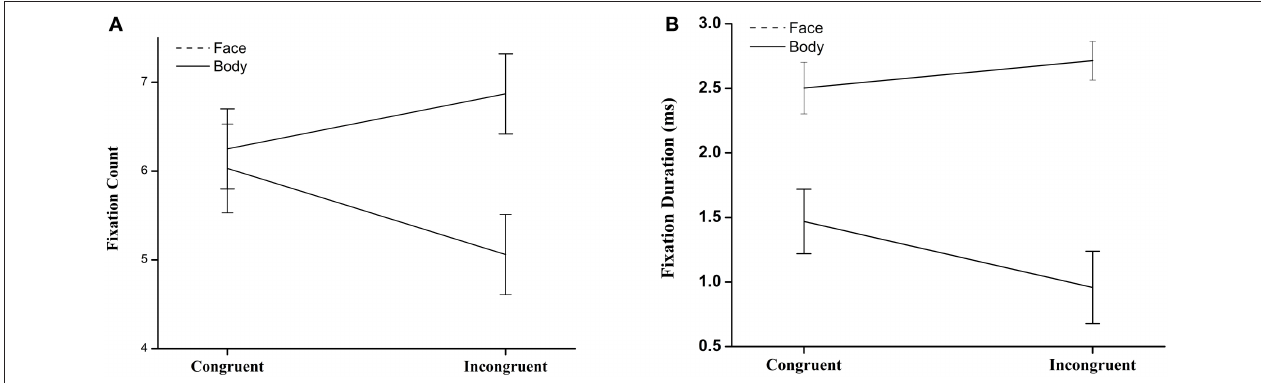
FIGURE 3 | (A) Number of fixation for Regions of Interest (ROI) of face and body in face-body compounds. (B) Fixation duration fixation for Regions of Interest (ROI) of face and body in face-body compounds.